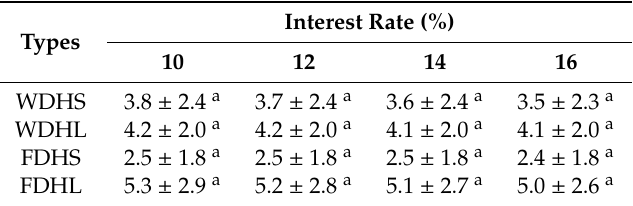
Table 7. Sensitivity of the B / C ratio on di ff erent home garden types and sizes to changes in di ff erent interest rates on 10%, 12%, 14%, and 16%.